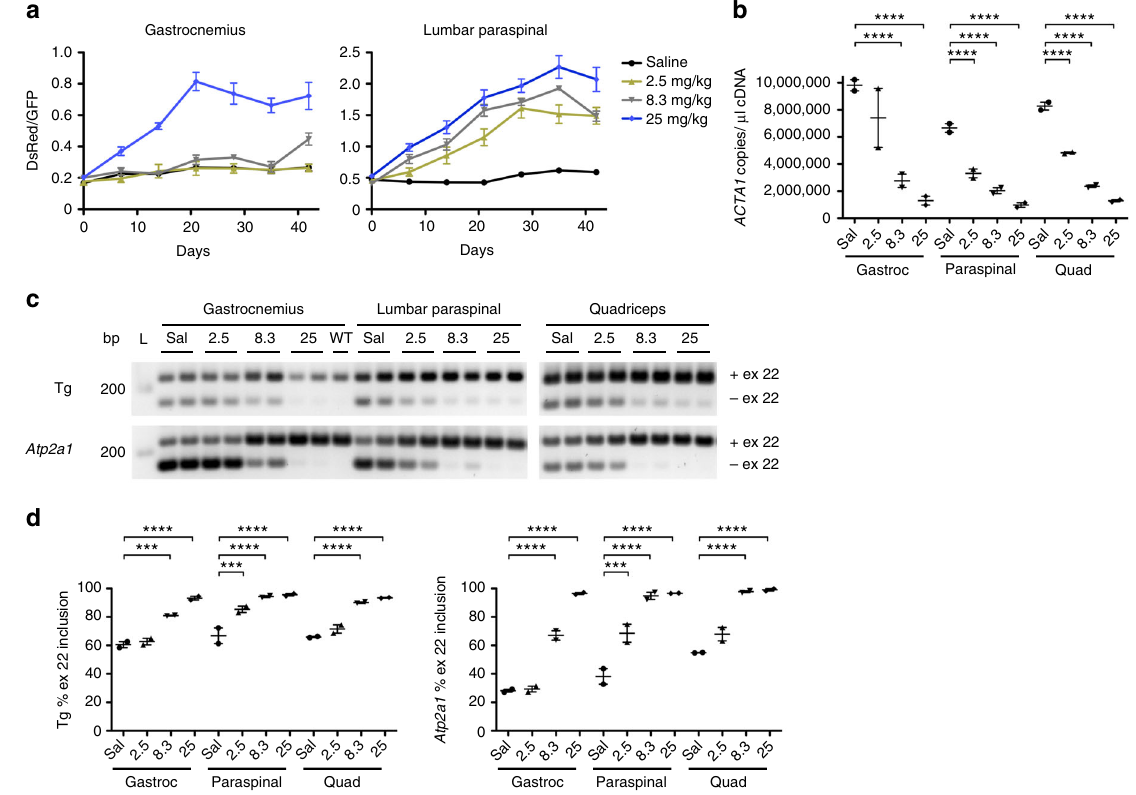
Fig. 6 In vivo activity of a novel ligand-conjugated antisense (LICA) oligonucleotide. We treated TR; HSA LR bi-transgenic mice with saline or a novel LICA oligonucleotide, ASO 992948, targeting ACTA1 -CUG exp transcripts and measured DsRed and GFP fl uorescence by serial in vivo spectroscopy. LICA-oligo doses were 2.5, 8.3, or 25 mg/kg twice weekly for 4 weeks (8 total doses) by subcutaneous injection ( N = 2 each group). However, due to low DsRed/GFP fl uorescence measurements in gastrocnemius muscles, mice receiving the 2.5 mg/kg and 8.3 mg/kg doses received four additional injections over the next 2 weeks, for a total of 12 doses. a Serial DsRed/GFP measurements in gastrocnemius and lumbar paraspinal muscles through Day 42. The fi nal dose in the saline (black circles) and 25 mg/kg groups (blue diamonds) was Day 24, while the fi nal dose in the 2.5 (yellow triangles) and 8.3 mg/kg (gray triangles) groups was Day 37. Error bars indicate mean ± s.e.m. b Quantitation of ACTA1 -CUG exp transcript levels (copies per microliter cDNA) by droplet digital PCR in muscles collected at Day 42. Error bars indicate mean ± s.e.m. **** P < 0.0001; two-way ANOVA. c Splicing analysis by RT-PCR in gastrocnemius and lumbar paraspinal muscles collected at Day 42. L DNA ladder, bp base pairs. d Quantitation of splicing results in c . Error bars indicate mean ± s.e.m. **** P < 0.0001, *** P < 0.001; two-way